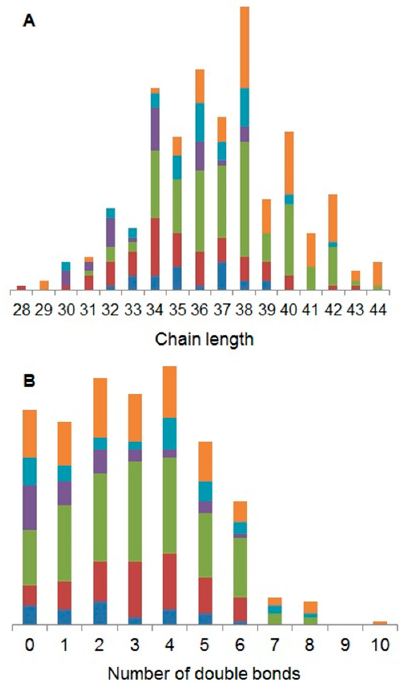
Figure 2. Bar charts showing the characteristics of the putatively annotated phospholipids in the D. magna baseline lipidome, specifically the distributions of chain lengths ( A ) and number of double bonds ( B ). Phospholipid class is shown by colour and order, bottom to top: PA (blue), PC (red), PE (green), PG (purple), PI (turquoise) and PS (orange).